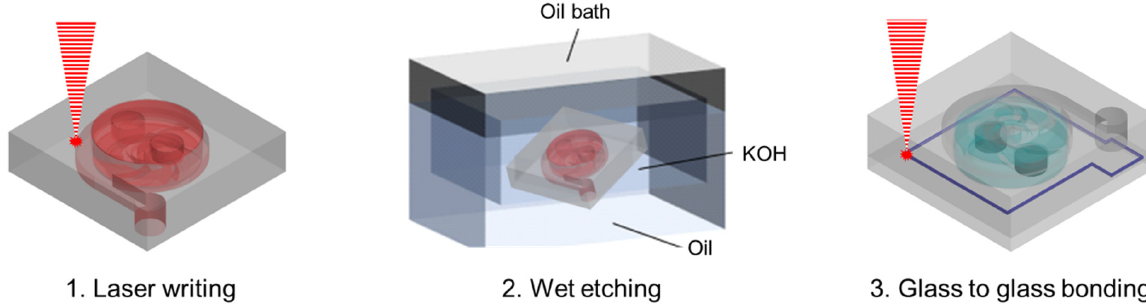
Figure 2. Fabrication process of the glass micropump.